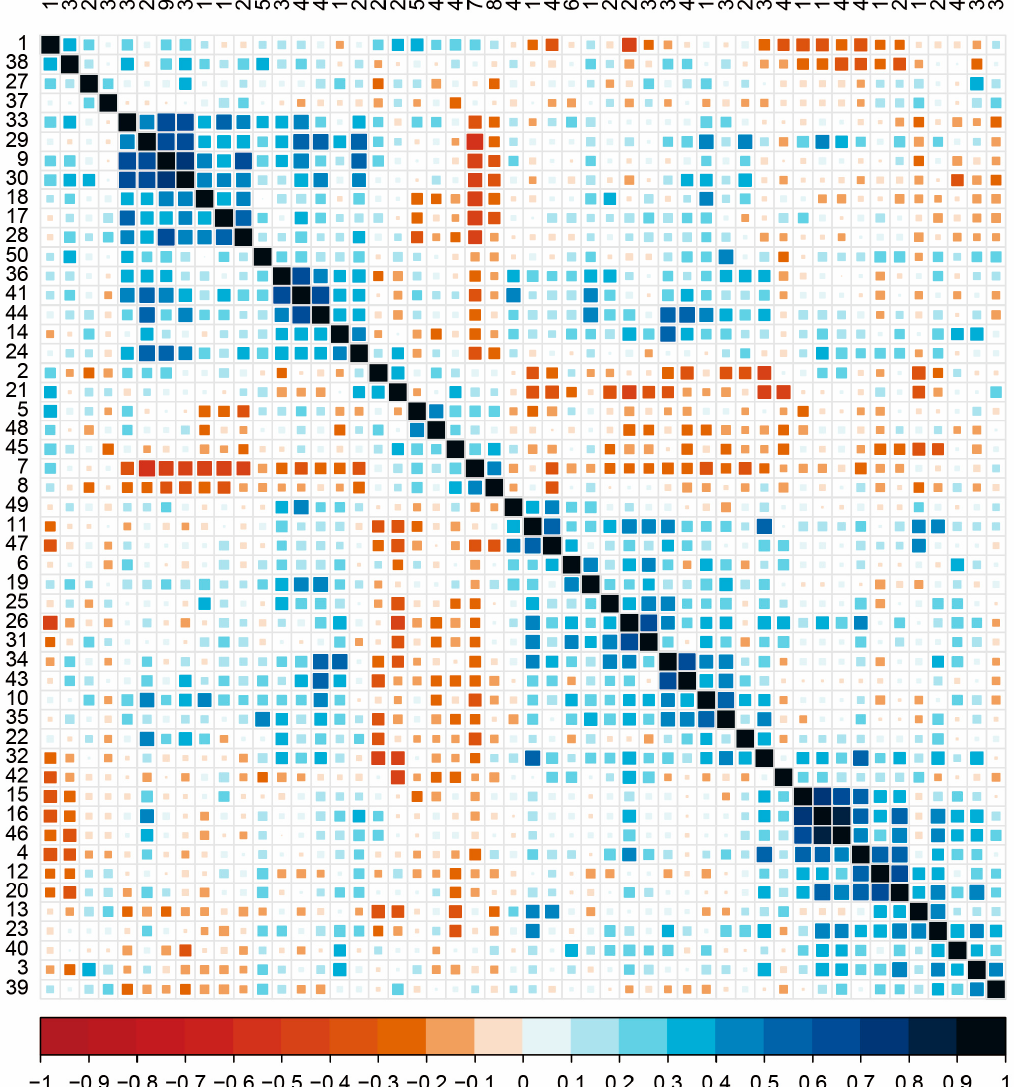
Figure 4. Heat map of the correlation between the statistical quantities of different gene families.